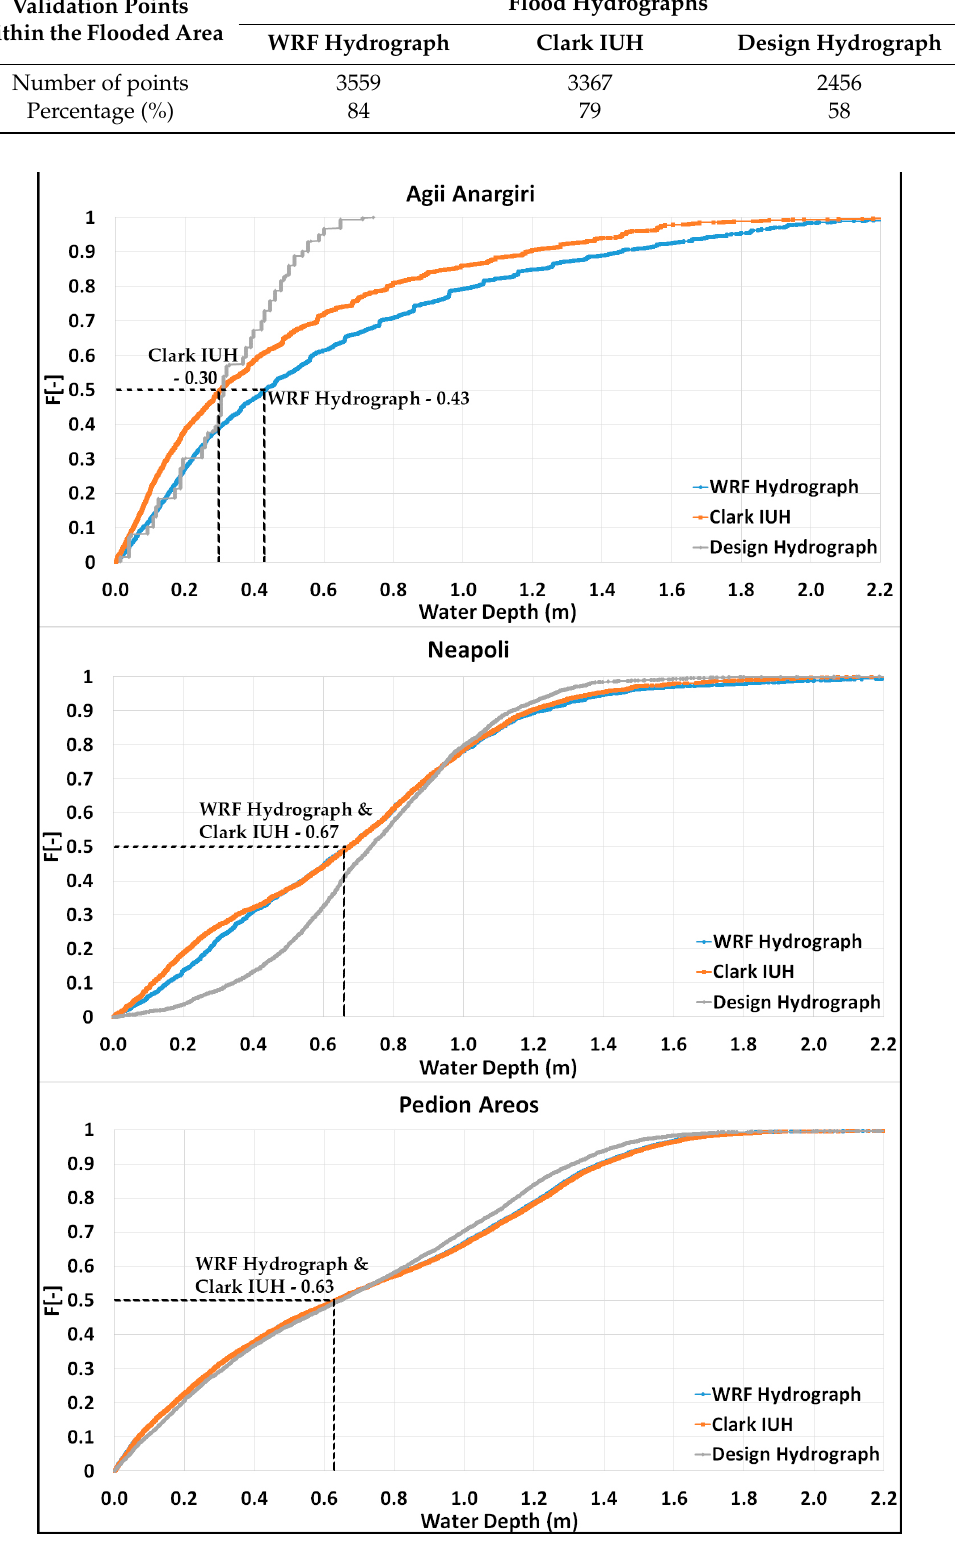
Figure 10. Cumulative distribution functions of the simulated water depths for the three majorly affected urban districts: Agii Anargiri, Neapoli, and Pedion Areos.